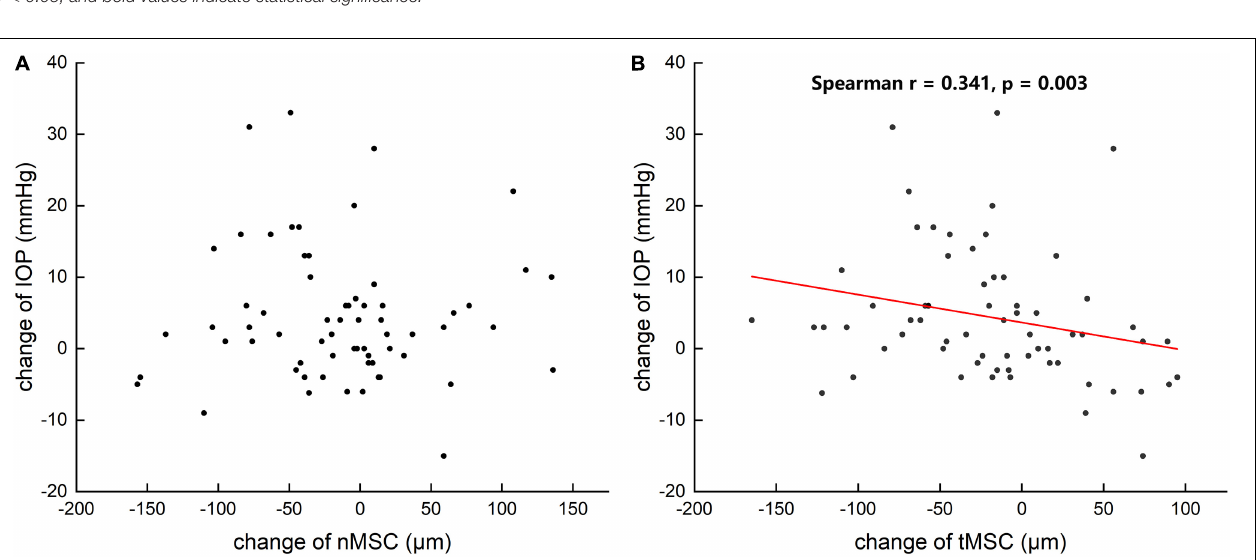
FIGURE 4 | Scattergrams showing the correlations between the changes in preoperative and postoperative intraocular pressure (IOP) and the changes in the nasal meridional diameter of Schlemm’s canal (nMSC) (A) and the temporal meridional diameter of Schlemm’s canal (tMSC) (B) in all subjects.